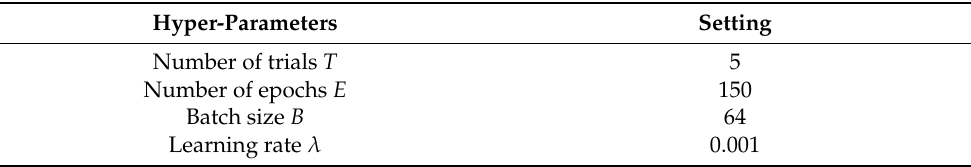
Table 4. Hyper-parameters for the model